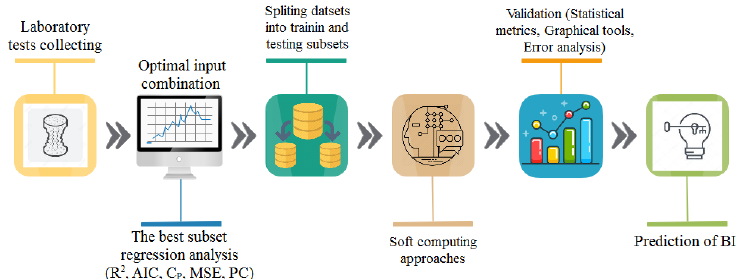
Figure 5. The road map of predicting BI using machine learning approaches.